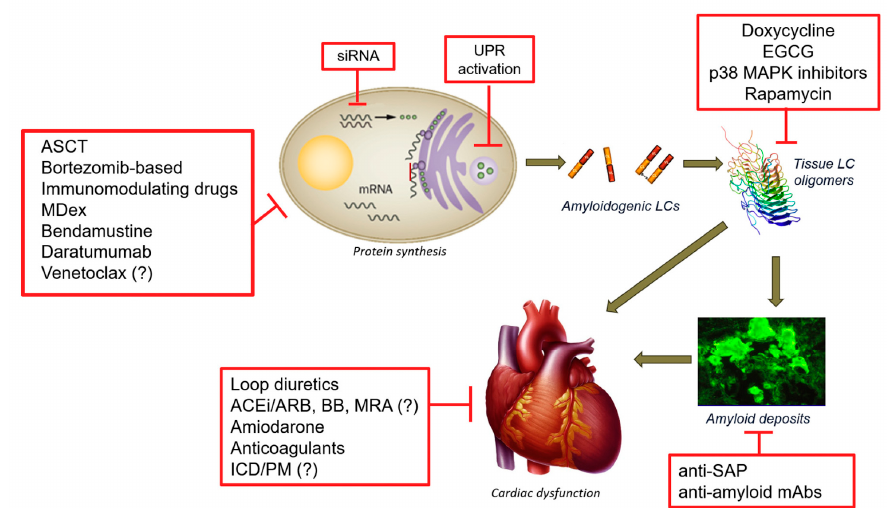
Figure 1. Targets for treatment in cardiac light-chain (AL) amyloidosis [4].